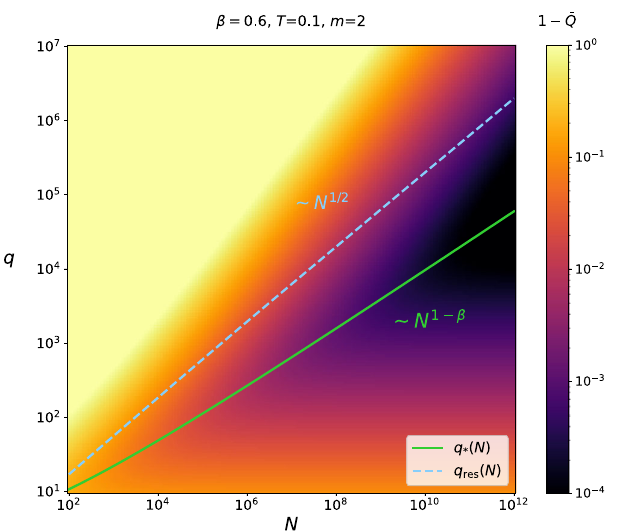
Fig. 3 The expected modularity as a function of N and q . For a better visibility, we plot 1 (cid:2) (cid:1) Q with the help of the colourmap, showing that (cid:1) Q can get very close to 1 already in the examined network size range. The continuous line corresponds to q * ( N ), whereas the dashed line shows q ð N Þ res